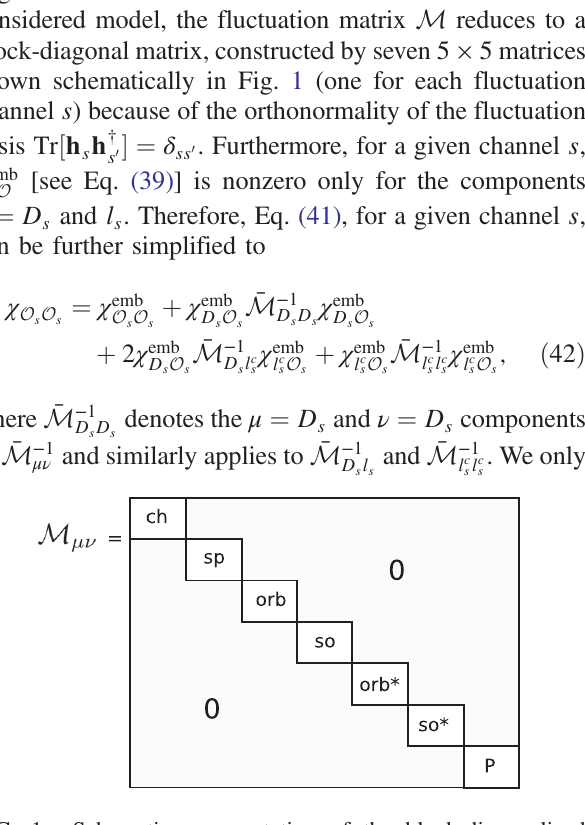
FIG. 1. Schematic representation of the block-diagonalized fluctuation matrix in the charge, spin, orbital, spin-orbital, and pairing sectors for the three-orbital degenerate Hubbard- Kanamori model [see Eqs. (4) and